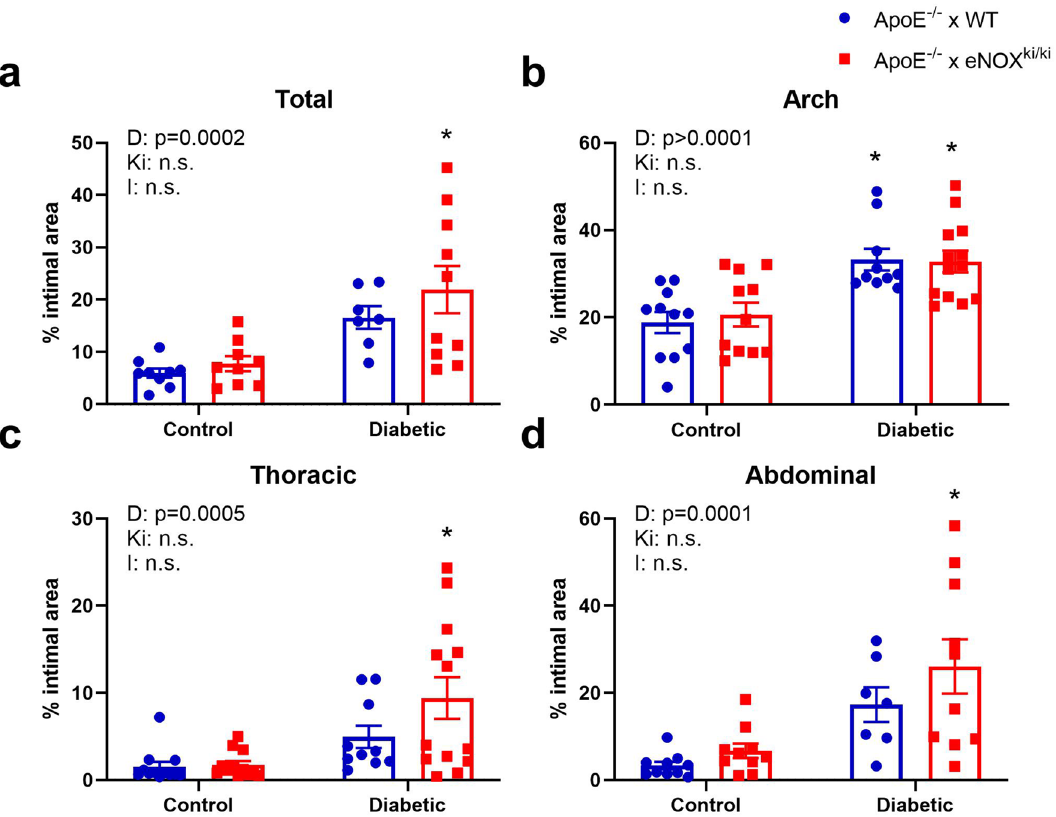
Figure 2. Endothelial NOX5 does not potentiate atherosclerosis in non-diabetic and diabetic ApoE −/− mice. Atherosclerotic plaque area was measured at 20 weeks after induction of diabetes in total aorta ( a ), aortic arch ( b ), thoracic aorta ( c ) and abdominal aorta ( d ). Animals with diabetes showed significantly greater levels of atherosclerosis however animals expressing endothelial Nox5 (red bars) did not have significantly different levels of intimal plaque area compared to ApoE −/− WT (blue bars). Data shown as mean ± SEM of n = 7–10 animals/ group. 2-way ANOVA: D- relative to diabetic status; Ki- relative to genotype (Nox5); I- interaction. * Tukey t-test versus relevant non-diabetic control P < 0.05. Representative images of en face mouse aorta from ApoE −/− mice stained with sudan IV are shown in Supplementary Fig. S5 online.